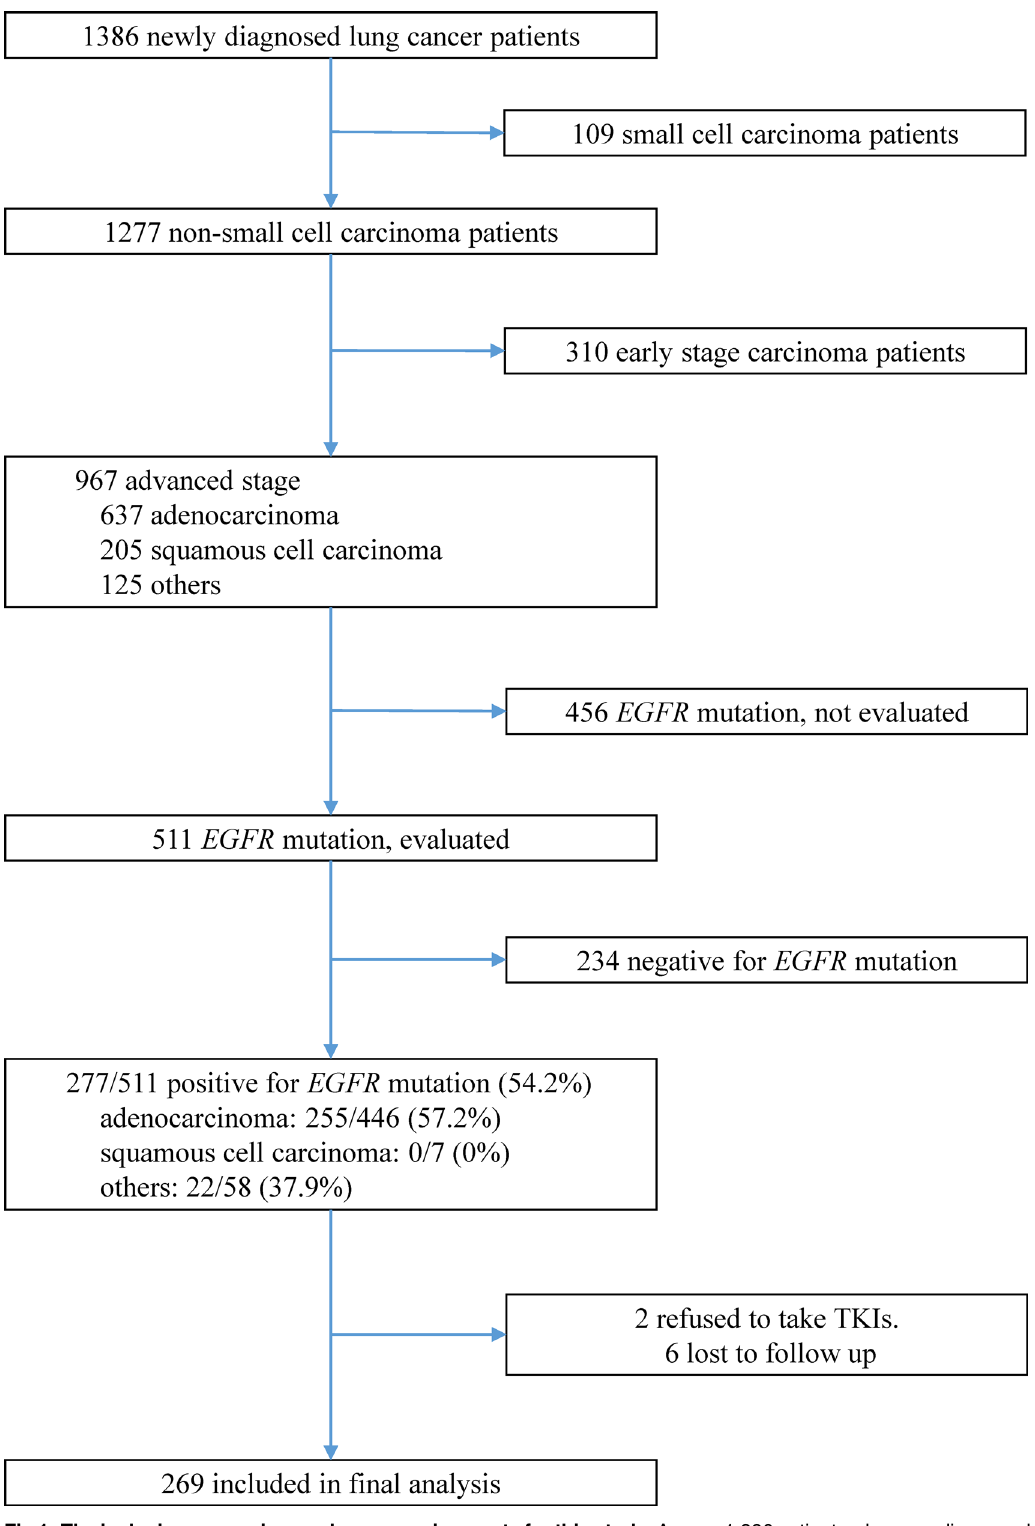
Fig 1. The inclusion, screening, and group assignments for this study. Among 1,386 patients who were diagnosed with non-small-cell lung cancer between January 2011 and January 2014, 269 patients were included in the final analysis.